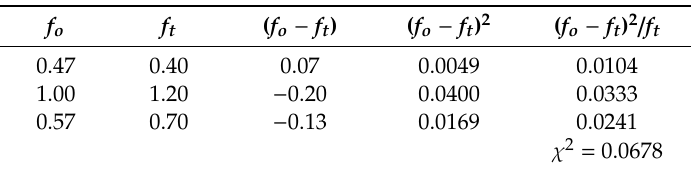
Table 2. χ 2 -test